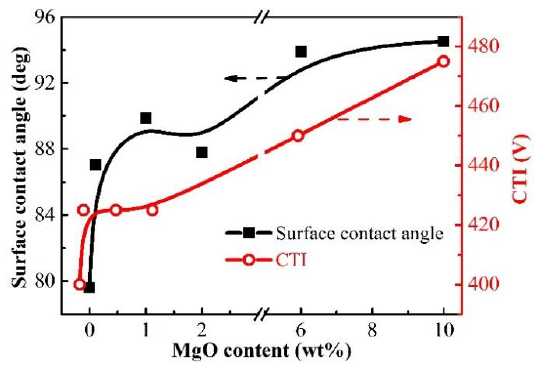
Figure 4. Comparison of surface contact angle and CTI of the nanocomposites.